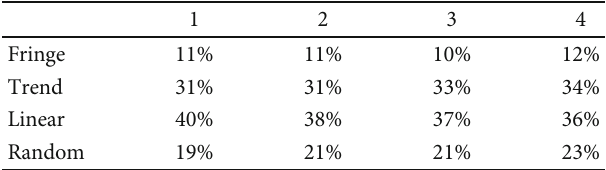
Table 1: Exercise strategy experiment